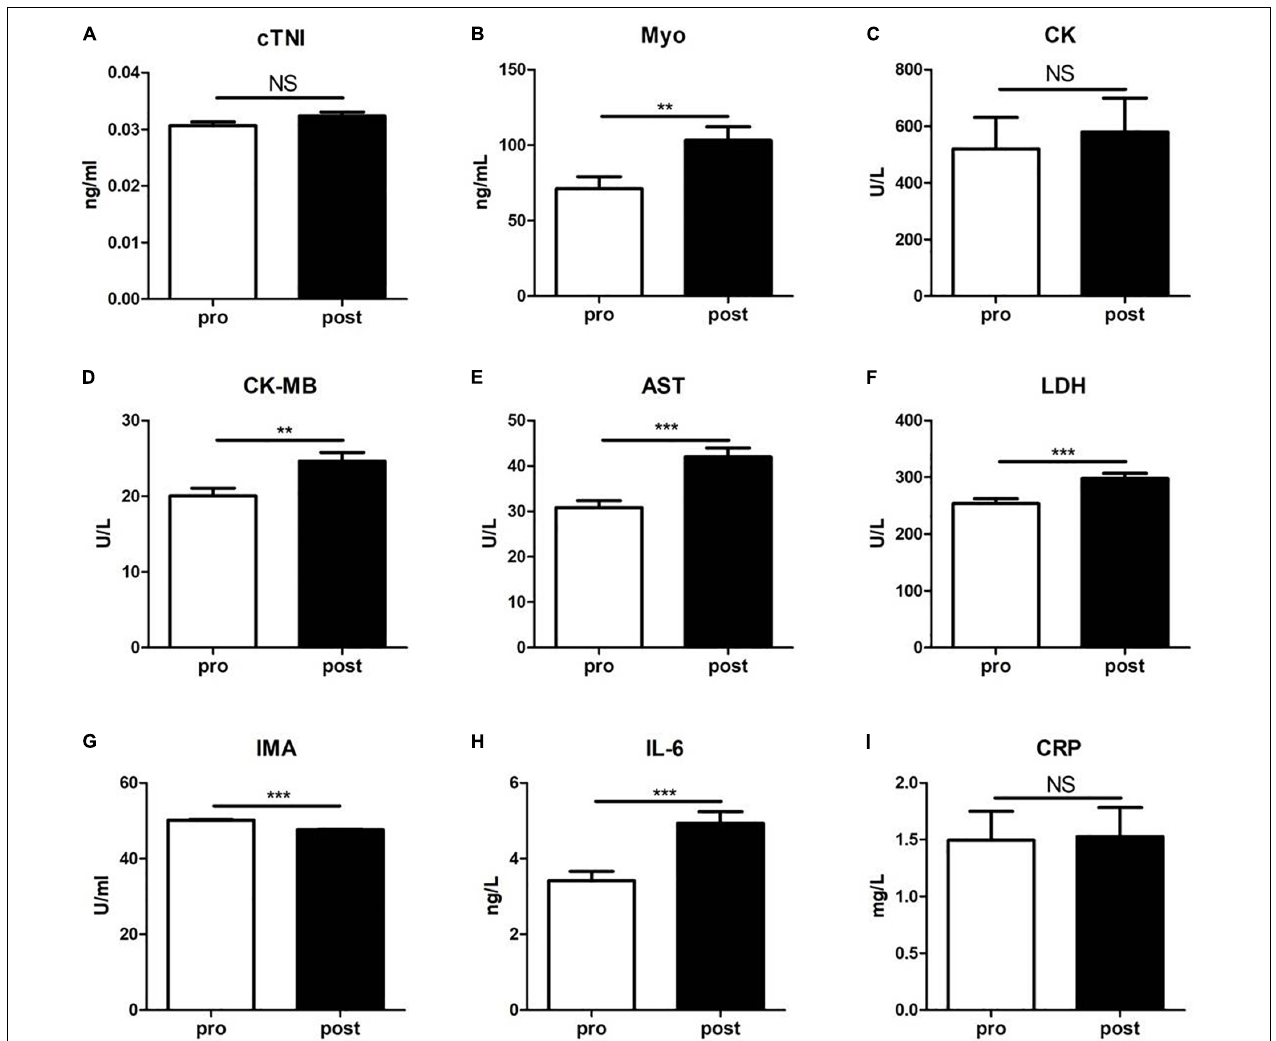
FIGURE 2 | The levels of a panel of cardiovascular diseases-associated clinical biochemical parameters were evaluated before (pre) and immediately after (post) the 5-km run test. (A) cardiac troponin I (cTNI); (B) myoglobin (Myo); (C) creatine kinase (CK); (D) creatine isoenzyme (CK-MB); (E) aspartate aminotransferase (AST); (F) lactate dehydrogenase (LDH); (G) ischemia-modified albumin (IMA); (H) interleukin-6 (IL-6); and (I) C-reactive protein (CRP). Data were analyzed using the unpaired t -test. The results are presented as the mean ± SEM, ** p < 0.01; *** p <